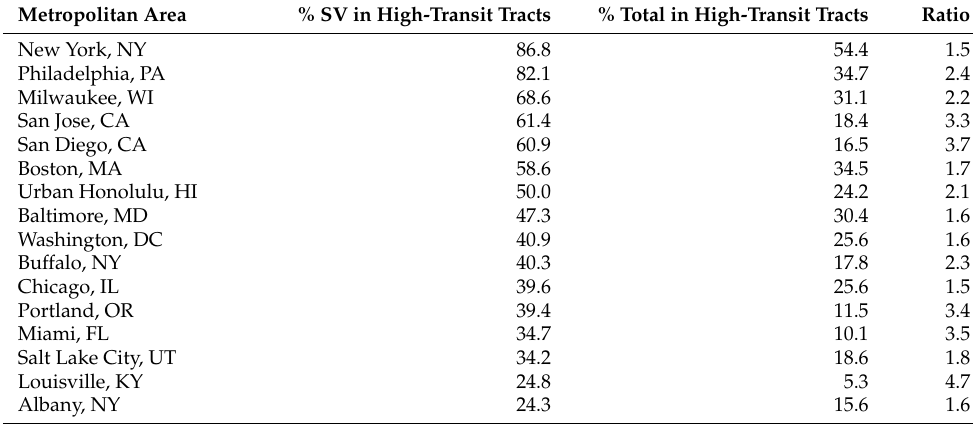
Table A2. Metropolitan areas ranked by proportion of urban population in high-SV census tracts also living in high-transit-accessible